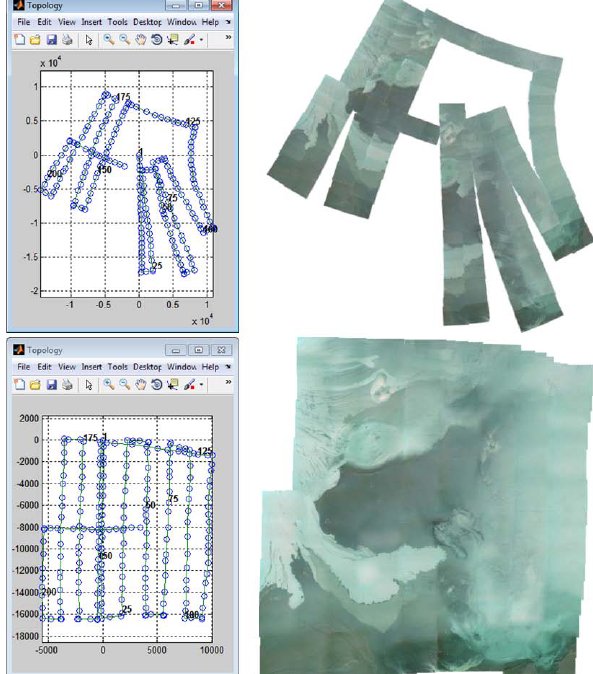
Fig. 7. Illustration of the benefits of using crossover points. Top: pairwise registration errors add up and lead to a huge global error. In this example, the right line of the mosaic corresponds to a featureless area, and the pairwise image registration is impacted by large errors. Bottom: the use of crossover points allows constrain- ing the error. The final mosaic is consistent. Each mosaic line is approximately 20m